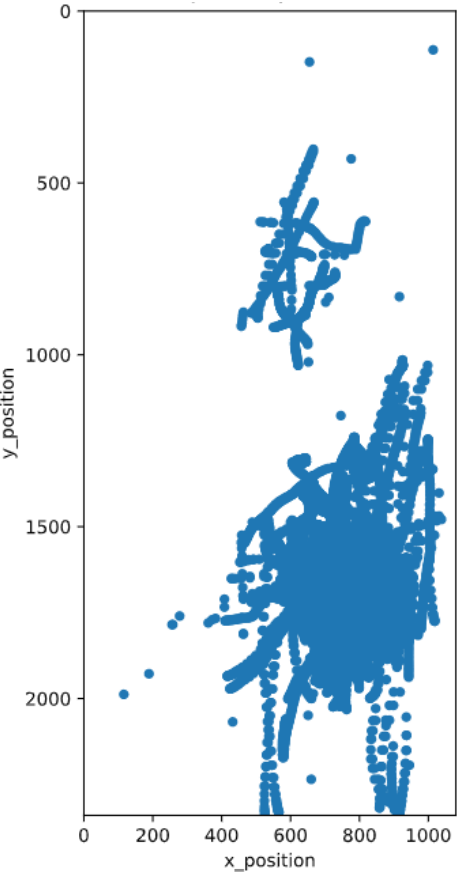
Figure 3. Multiple gestures visualized at display scale, showing that a user most of the time interacts with a specific portion of the